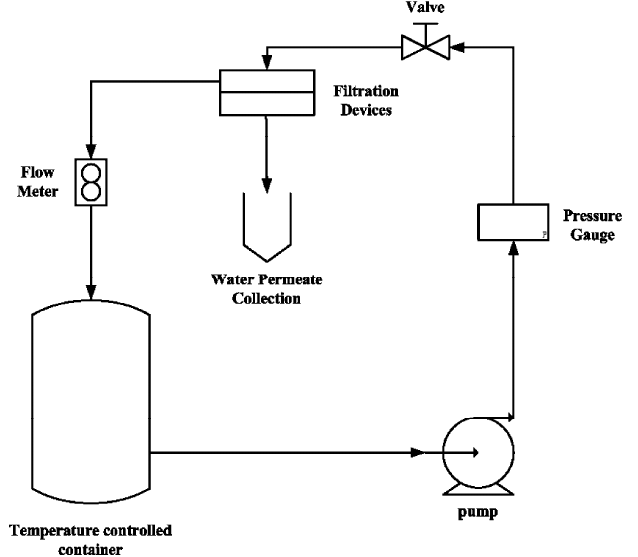
Figure 6. Schematic diagram of self-built temperature controlled